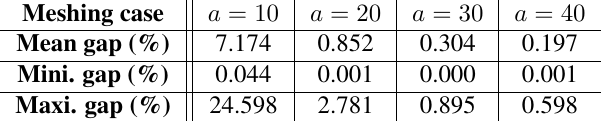
Table 1: Statistical (mean, minimum, mini., and maximum, maxi.) relative gaps (see relation (4)) from one meshing test case (see Fig. 1) to another (i.e. from meshing mean elementary cell around ∆ = λ 0 /a to ∆ = λ 0 / ( a + 10) ).